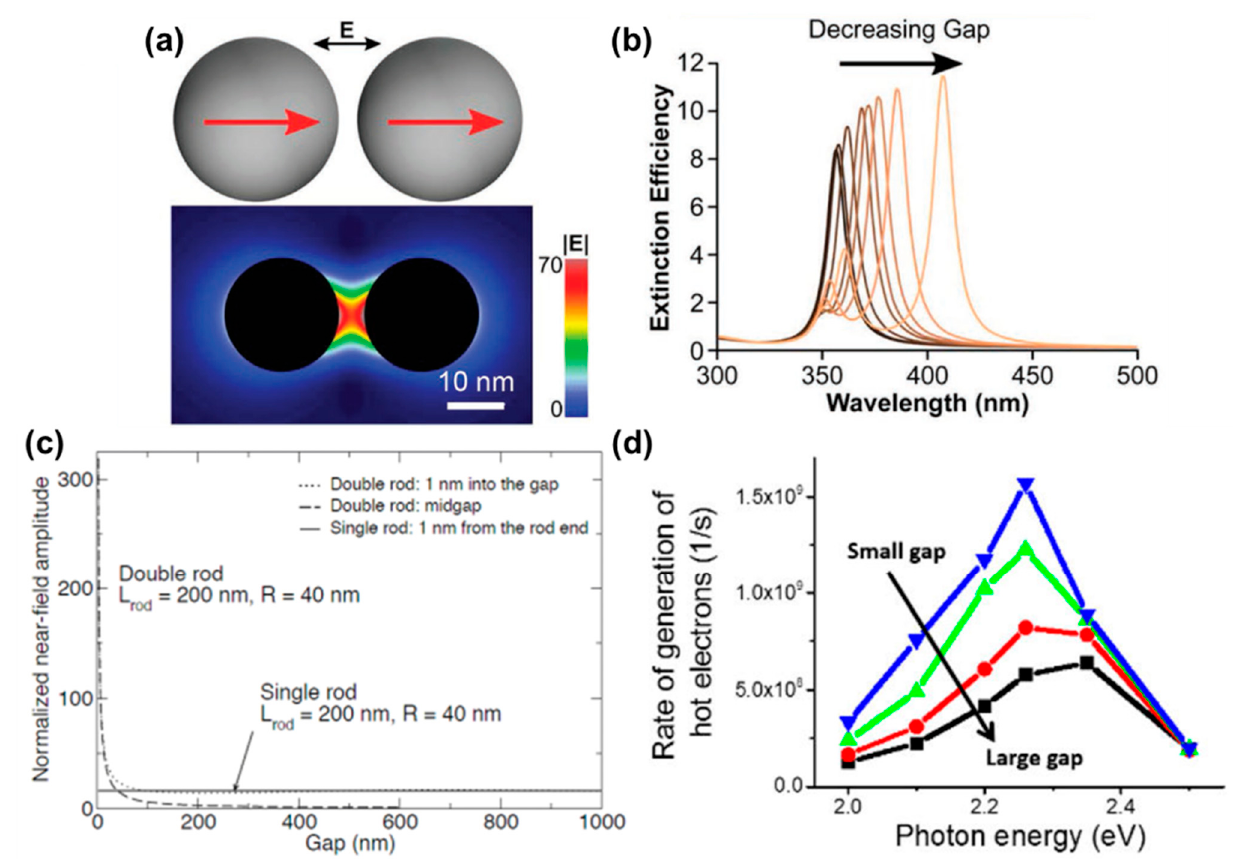
Figure 3. Enhanced E-field at metal nanogaps. ( a , b ) Ag NP dimer. ( a ) Schematic (top) and simulated E-field contour map (bottom) showing the large E-field enhancement in the gap region. ( b ) Simulated extinction efficiency as a function of gap size, showing the characteristic red shift of the LSPR with decreasing gap length due to the increased coupling between the two induced dipoles. ( c ) Near-field amplitude of a pair of identical Au NRs, coupled end-to-end, as a function of gap separation. The NRs were irradiated with a plane wave with longitudinal polarization. Corresponding results for an isolated rod are also indicated. ( d ) Simulated rate of hot electron generation within Au NP dimers (3 nm radius), going from a 1 nm gap to an infinite gap (blue curve to the black curve). ( a , b ) Reprinted from ref. [16]. Copyright 2016 American Chemical Society. Further permission related to the material excerpted should be directed to the ACS. ( c ) Reprinted from ref. [4]. Copyright 2008 WILEY-VCH ( d ) Reprinted with permission from ref. [38]. Copyright 2016 American Chemical Society.